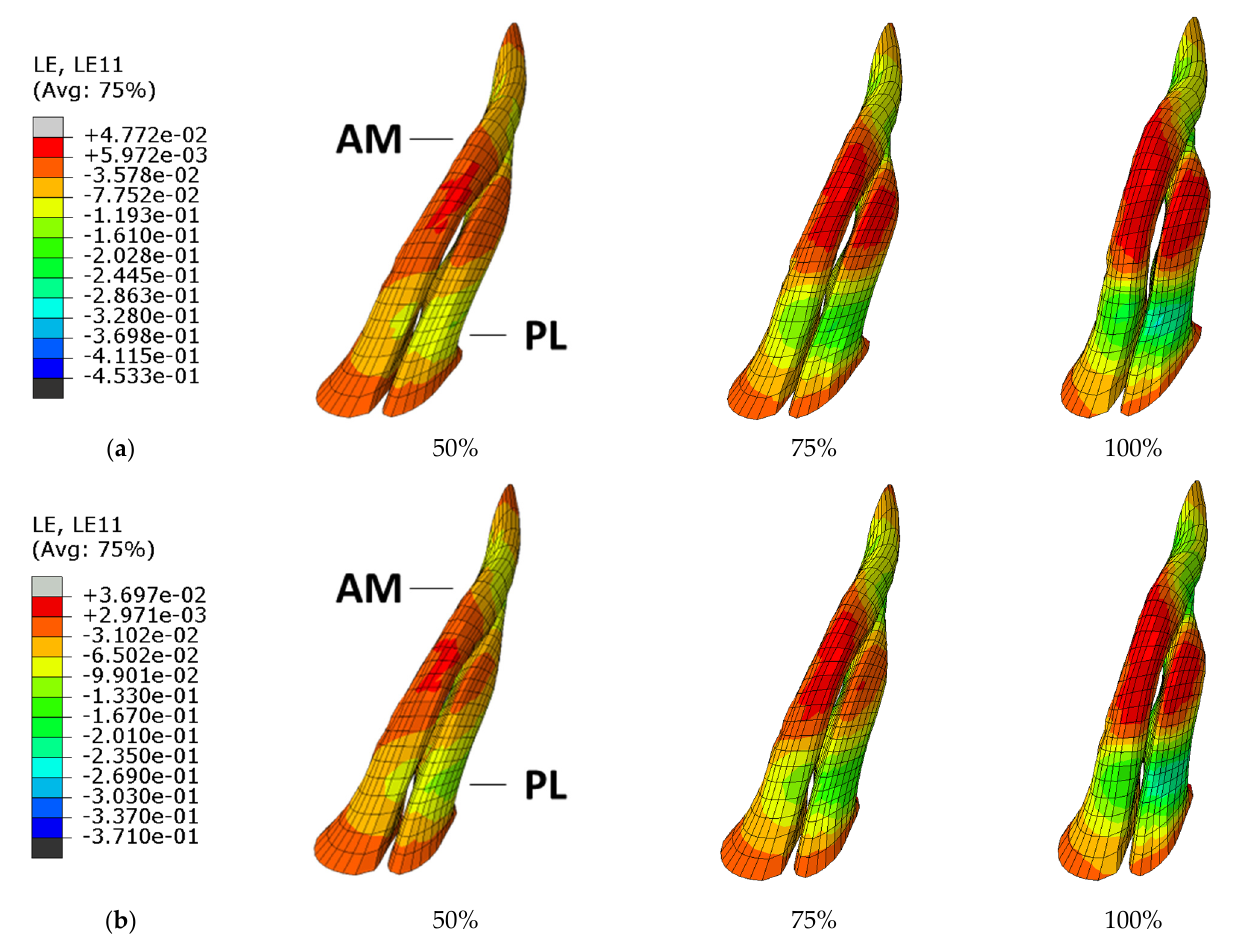
Figure 6. Strain evolution in the ACL bundles during ( a ) simulation #6 [ER] and ( b ) simulation #14 [IR].